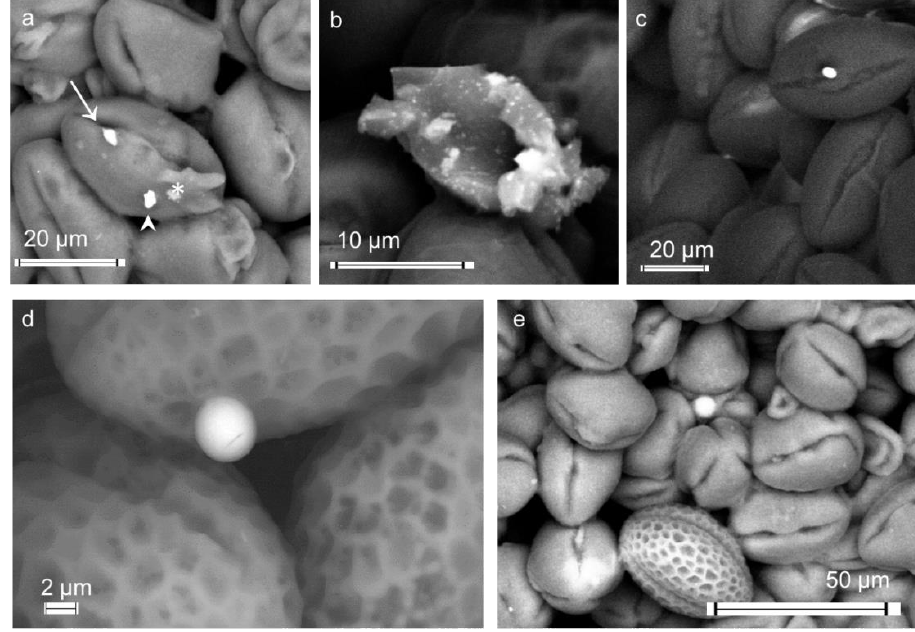
Figure 5. ( a ) Pollen grains of Medicago sativa contaminated with PM of quartz (arrow, 4.2 μm), clay mineral (asterisk, 2.9 μm) , and metallic Zn (arrowhead, 3.8 μm ). ( b ) PM containing lead (brighter areas). ( c ) PM of antimony oxide (2.7 μm ). ( d , e ) Round-shaped SiO 2 particles (4.2 μm and 4.3 μm).